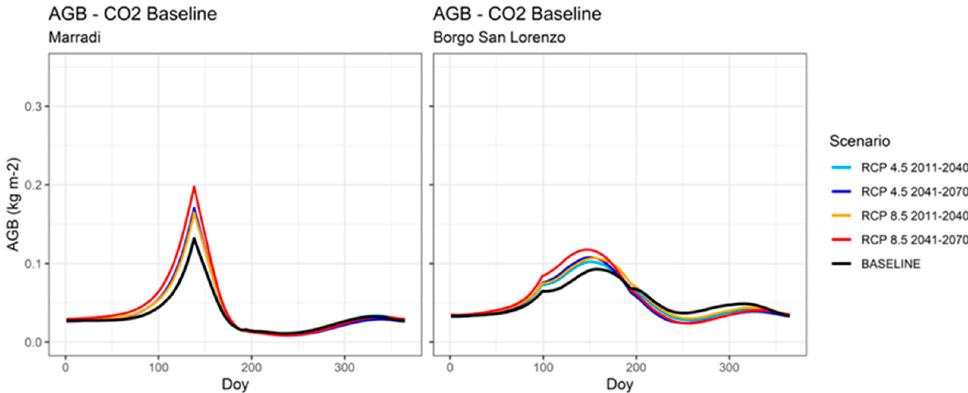
Figure 7. Daily simulation (30-year mean) of aboveground biomass (AGB) with PaSim for baseline and climate change scenarios (no CO 2 fertilization) under business-as-usual management at both study sites.